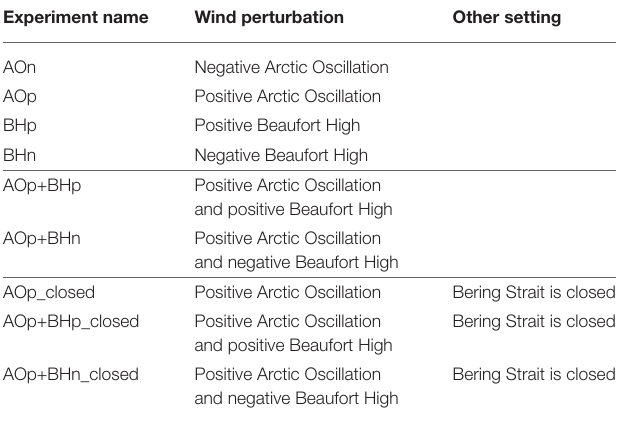
TABLE 1 | List of wind perturbation simulations used in this study.